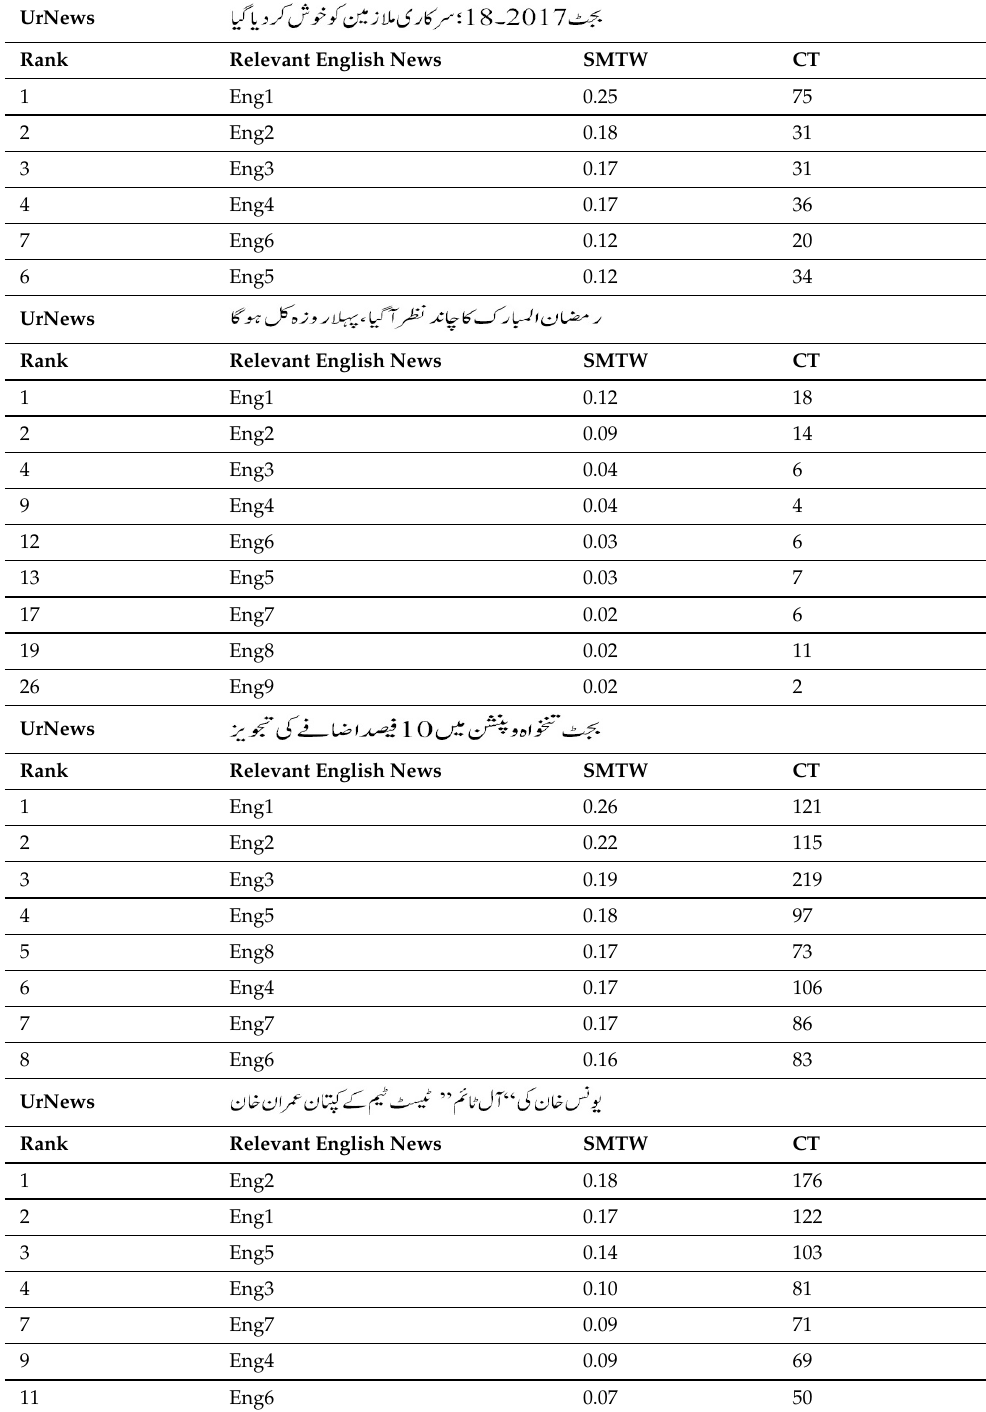
Table 7. Computed similarity for one day news articles using